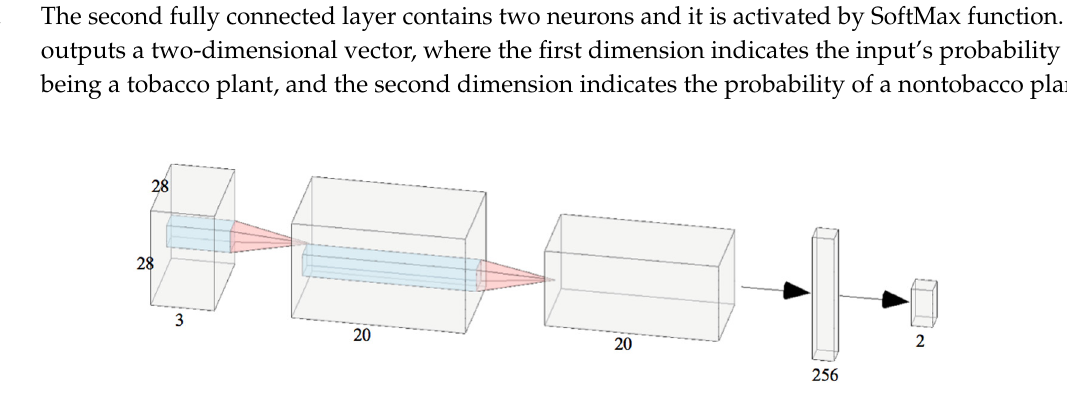
Figure 5. Network architecture. The input image is a colored region that we extract from the original aerial image. The first layer is a convolutional layer with 20 filters. The convolutional layer is connected to a max pooling layer whose pool-size is 2 × 2. After the pooling layer are two fully connected layers.